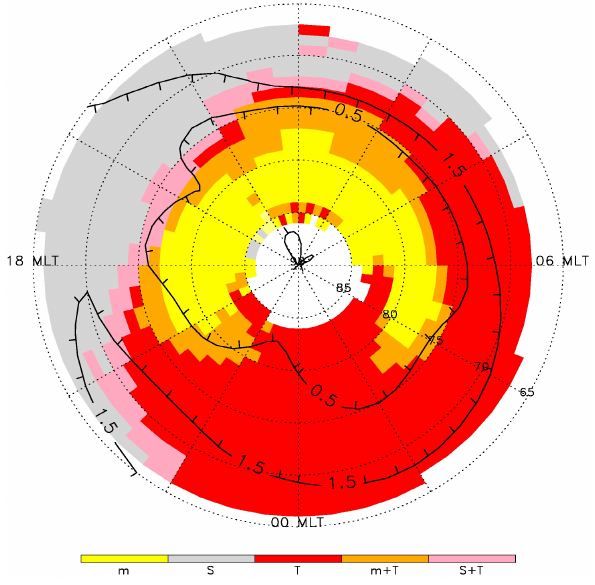
Fig. 6. Isocontours of the average energy of electron precipitation as defined by the model of Hardy et al. (1987), superimposed on the dominant ACF class.